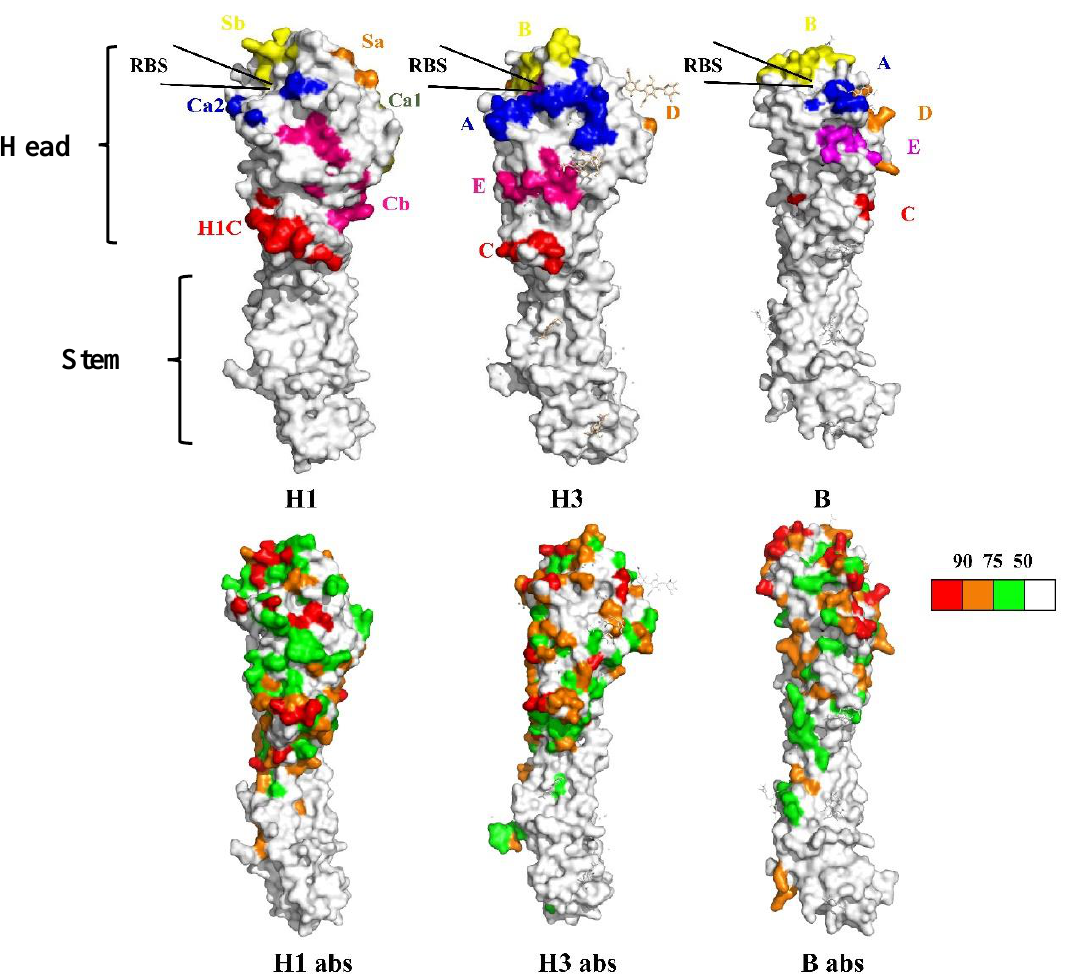
Figure1. Mutationfrequencyofdi ff erentantigenicregionsandsurfaceaminoacidsinthehemagglutinin (HA) protein of influenza viruses. H1 represents the 3D structure of A / Puerto Rico / 8 / 34 (H1N1) HA protein (PDB ID: 1RU7) on which the location and distribution of di ff erent antigenic regions (Ca1, Ca2, Sa, Sb, Cb, and H1C) are indicated. H3 represents the 3D structure of A / X-31 H3 subtype HA protein (PBD ID: 2VIU) illustrating the location and distribution of di ff erent antigenic regions (A, B, C, D, and E). B represents the 3D structure of B / Lee / 40 B subtype HA protein (PDB ID: 1RFT) highlighting the location and distribution of di ff erent antigenic regions (A, B, C, D, and E). H1 abs, H3 abs, and B abs illustrate the mutation frequency of surface amino acids on the respective HA proteins, with their color representing the intensity of mutation frequency based on H1N1 ( n = 531, isolated between 1918–2008), H3N2 ( n = 968, 1968–2005), and flu B ( n = 209,